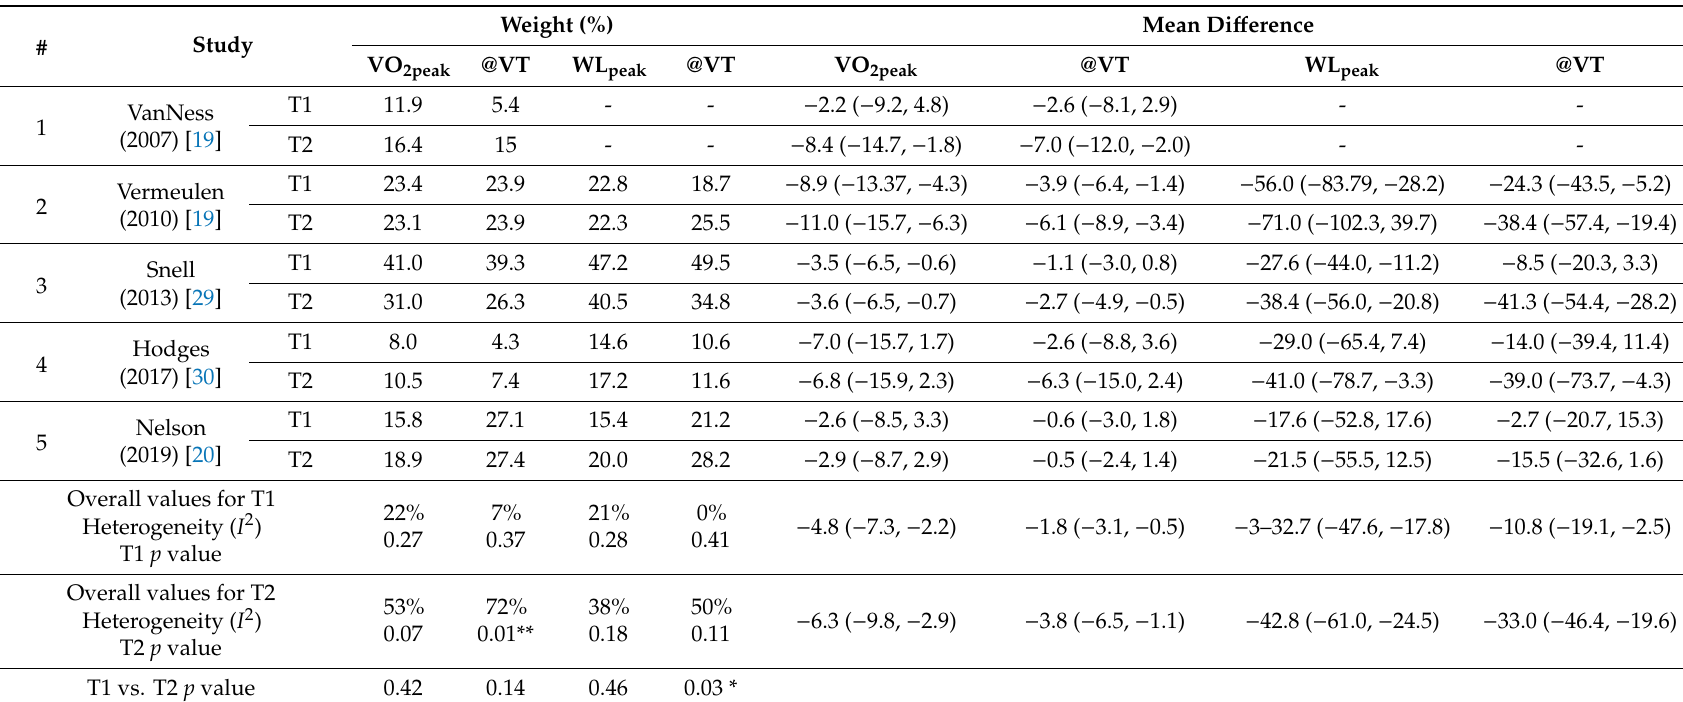
Table 4. Meta-analysis (of ME / CFS patient control) for the comparisons between the two-day CPET 1 and